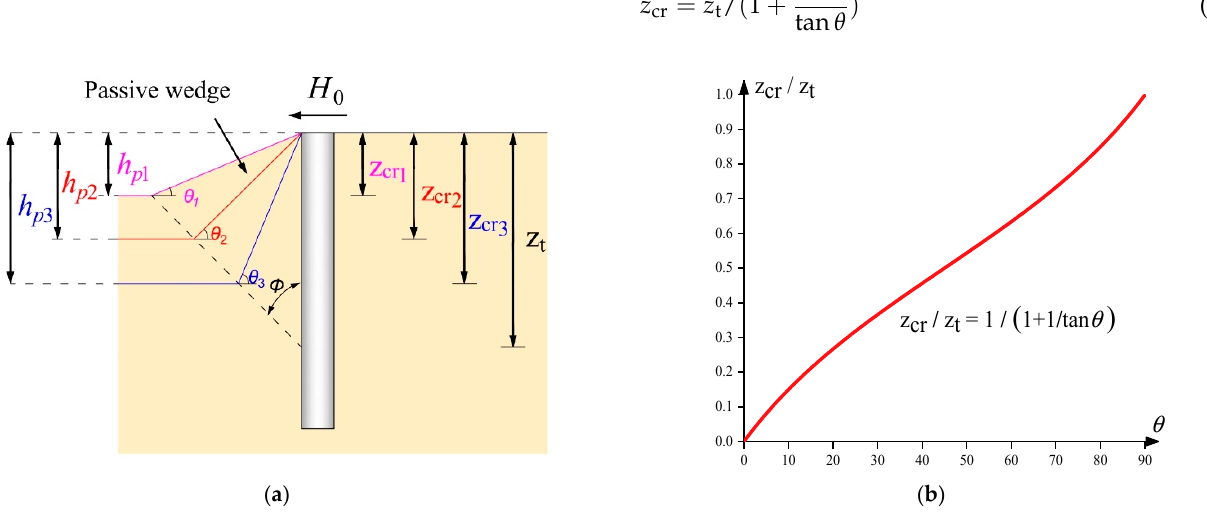
Figure 12. ( a )Different passive wedges with slope angle ( 𝜃 ) and ( b ) variation of 𝑧 (cid:2913)(cid:2928) with slope angle ( 𝜃